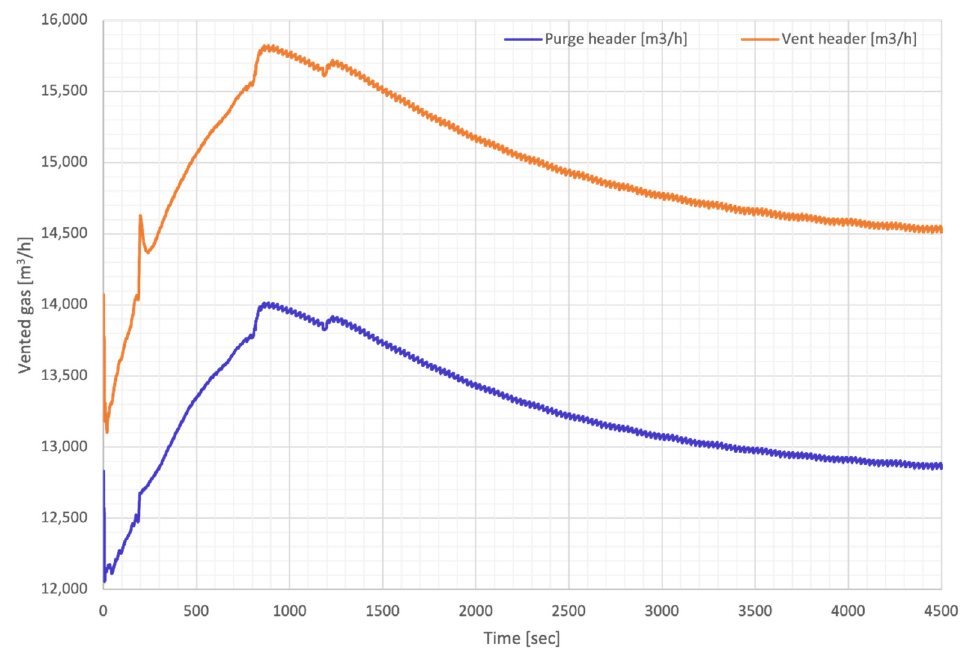
Figure 11. Volumetric gas flow vented by each 20 inches piping.